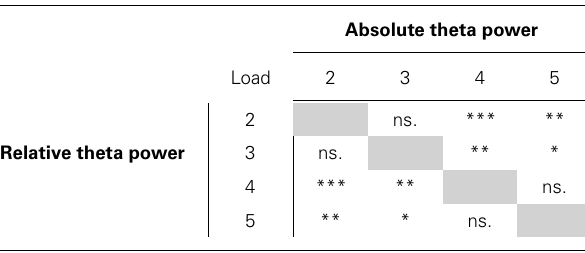
Table 2 | Load-related theta power increases in highWMC